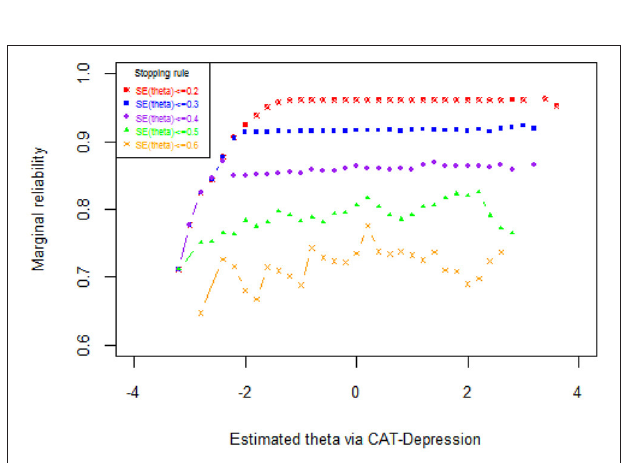
FIGURE 2 | Reliability as a function of the theta under several stopping